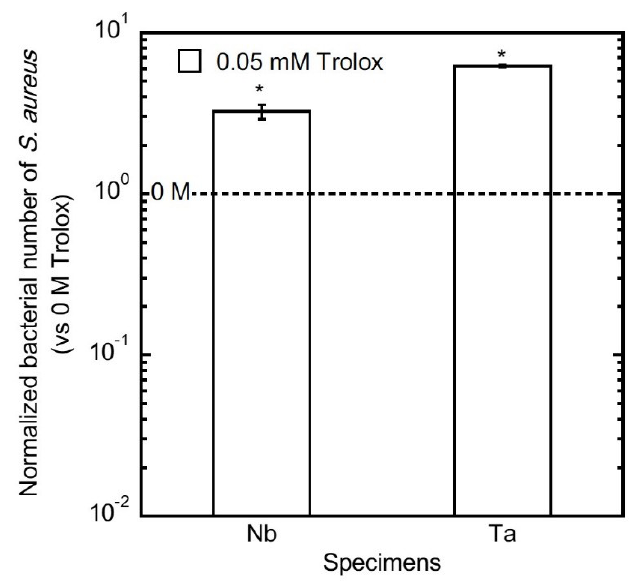
Figure 6. The number of S. aureus in 0 and 0.05 mM Trolox-containing bacterial suspension incubated on each specimen. Data are shown as the mean ± SD. *: Significant difference against 0 M Trolox. (ANOVA + SNK ( P < 0.05, N = 5)).